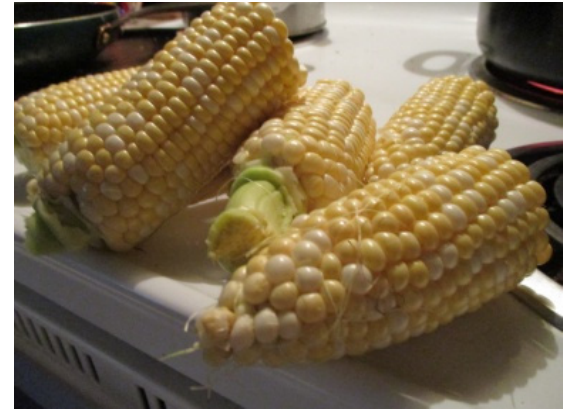
Figure 1. Margaret, 22.